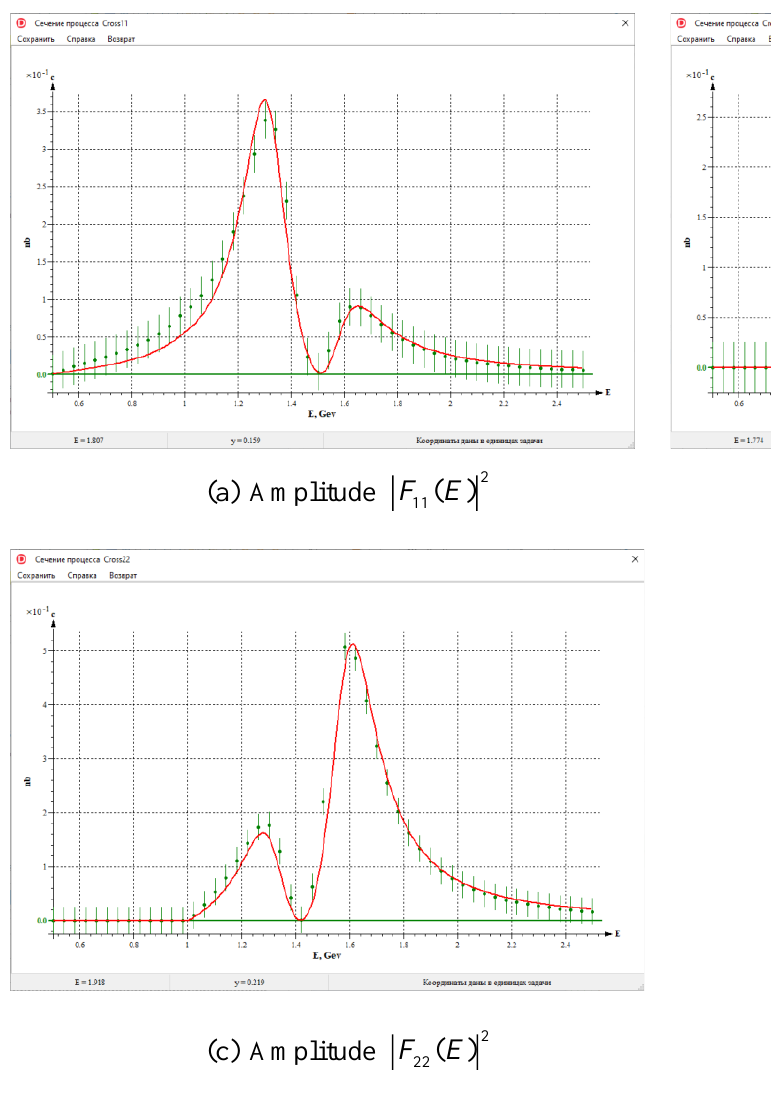
Figure A6. Unitary BW scattering amplitudes. Fitting BW parameters in Figure A6 are: